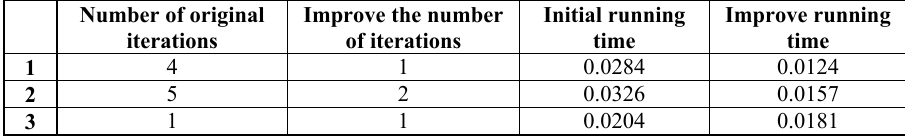
Table 3. Before and after the improvement of the RANSAC